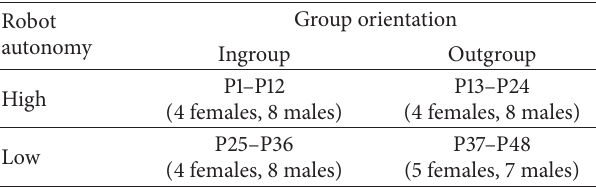
Table 3: Between-subject design of the